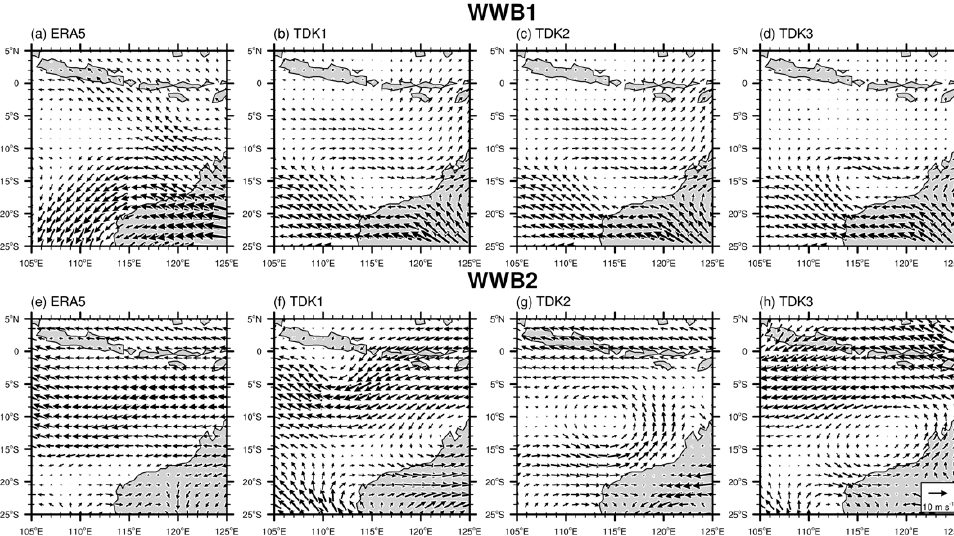
Figure 10. Horizontal circulations of 850 hPa winds (m s − 1 , vectors) for ( a , e ) ERA5, ( b , f ) TDK1, ( c , g ) TDK2, and ( d , h ) TDK3 experiments. The upper (bottom) panels display two-day averaged results when the WWB1 (WWB2) convective center is located near 90 ◦ E. The shading represents the land.